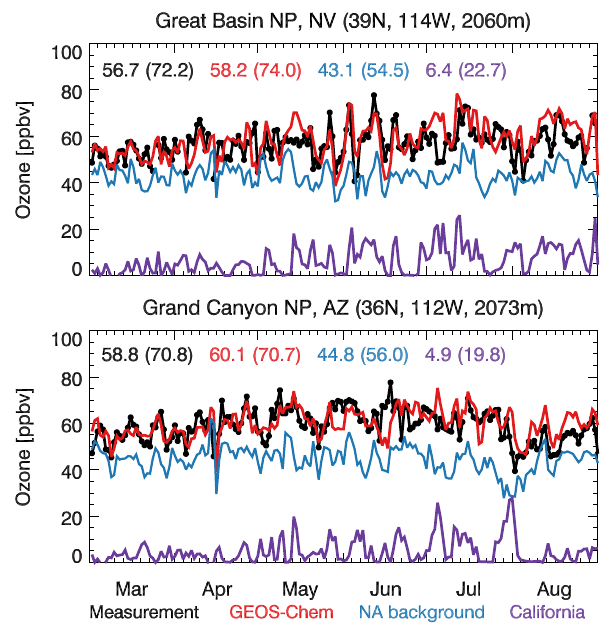
Figure 13. March–August time series of MDA8 ozone concentra- tions at Great Basin NP, Nevada, and Grand Canyon NP, Arizona, in 2006. Observations (black line) are compared to model results (red line). Also shown is the North American background (blue line), and ozone enhancements from California anthropogenic emissions (purple line) as determined from a sensitivity simulation with that source shut off. The mean concentrations for the time period and the annual fourth highest values are shown